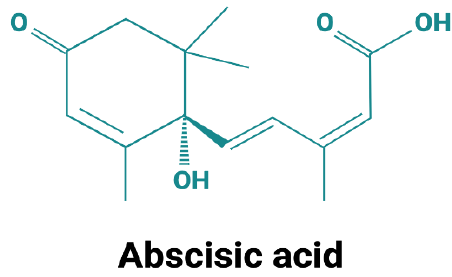
Figure 1. Structure of abscisic acid. Abscisic acid exists in two enantiomers: S -(+)-ABA, which is the predominant form in plants, and R -( − )-ABA. Most studies in mammals employed a racemic mixture. When individually tested on innate immune cells, both ABA enantiomers were similarly effective in the induction of an intracellular Ca 2+ increase and in stimulating chemotaxis [1].